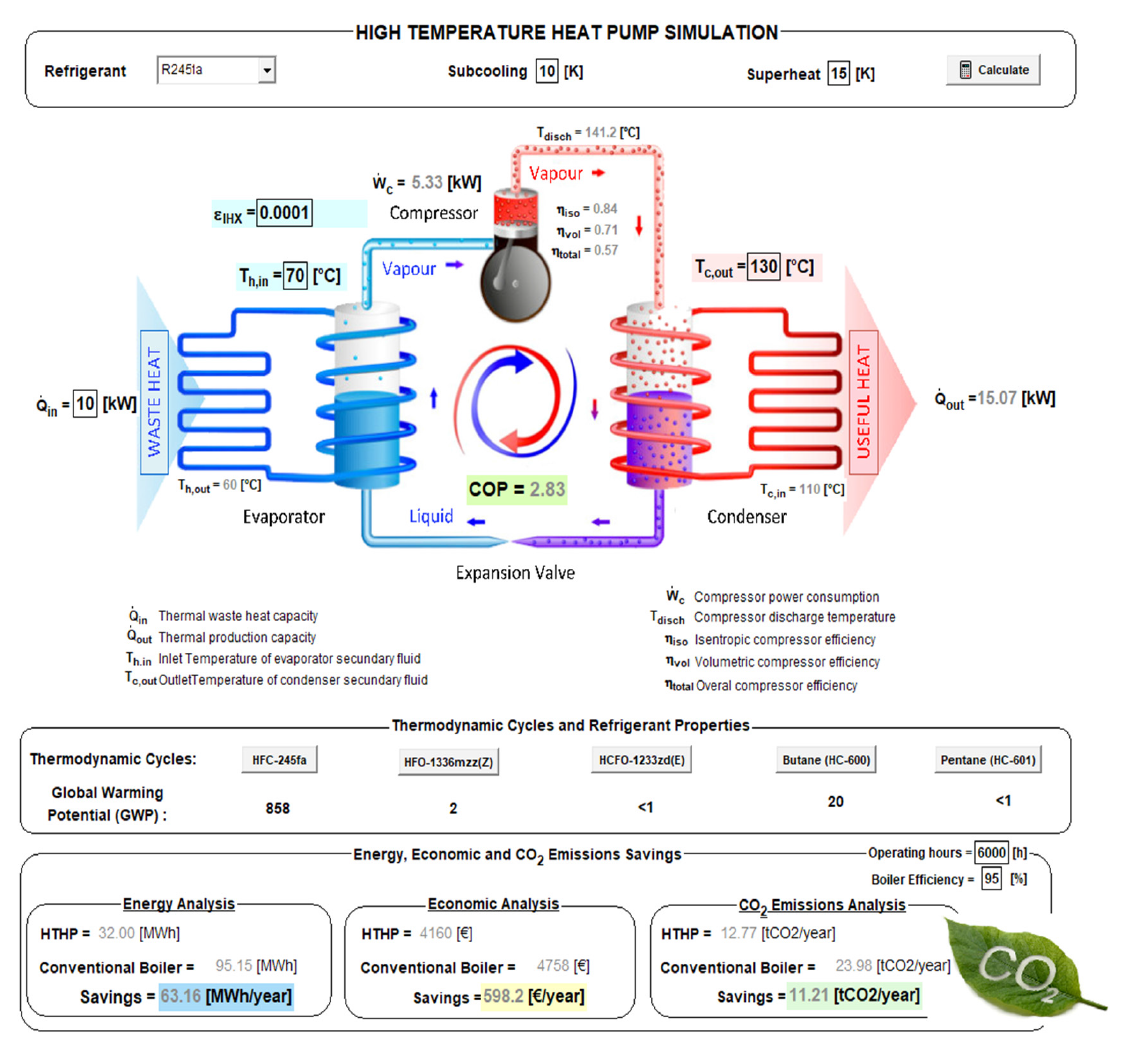
Figure 3. HeatPack main screen and